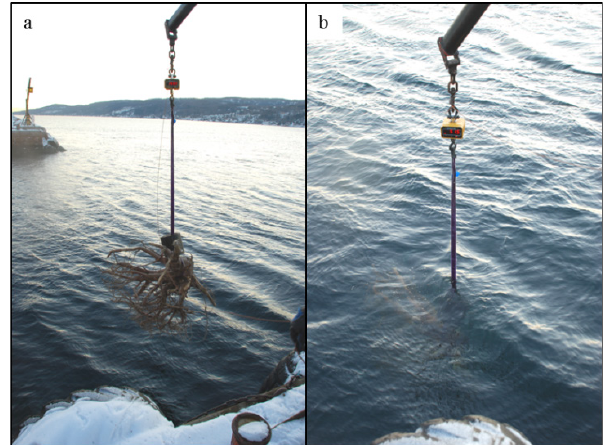
Figure 1. Images of the volume estimation method used for the root systems: ( a ) Weighing the root system in the air; ( b ) Weighing the root system in the